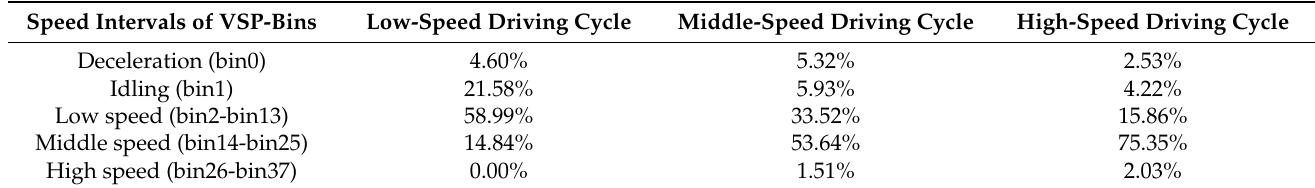
Table 5. The distribution frequency of different vehicle typical driving cycles in different speed intervals of